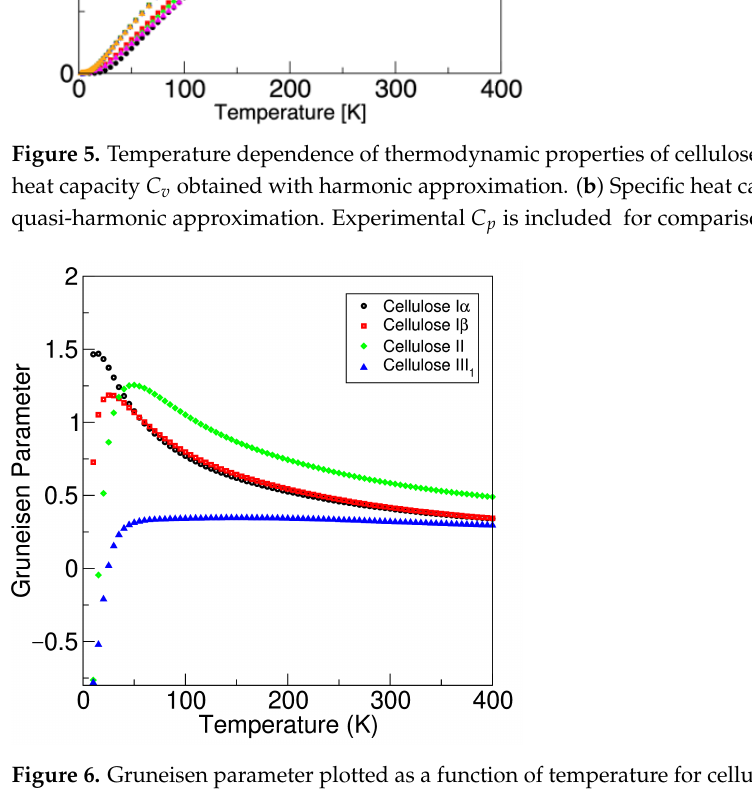
Figure 6. Gruneisen parameter plotted as a function of temperature for cellulose allomorphs I α , I β , II, and III 1